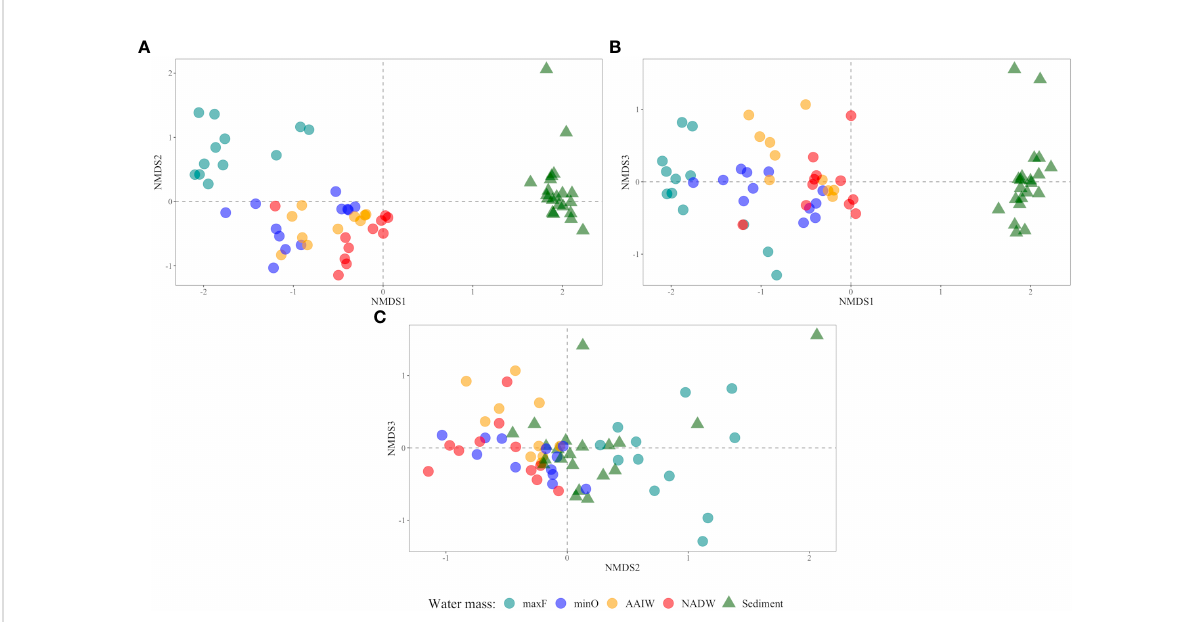
FIGURE 5 Comparative analyses of microbial communities based on non-metric multidimensional scaling (NMDS) ordination axis: (A) 1 vs 2, (B) 1 vs 3, and (C) 2 vs 3). The sediment samples are represented by a triangle ( ▴ ) and water samples by a circle ( (cid:129) ) according to water masses (maxF, minO, AAIW,